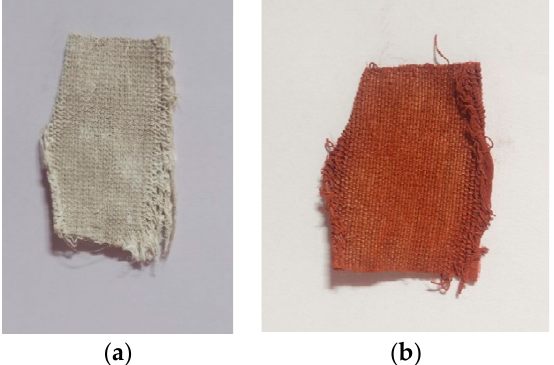
Figure 1. ( a ) Sisal fiber after zinc oxide coating wash; ( b ) sisal fiber after iron oxide coating.